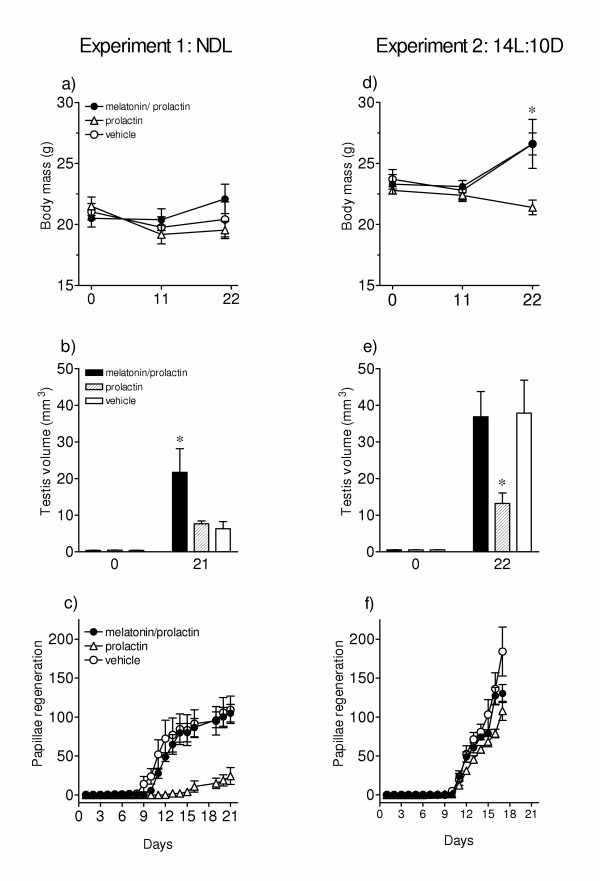
Mean (± SE) body mass, testis volume and feather papillae regeneration in response to treatment with melatonin and prolactin (group 1), prolactin alone (group 2), or vehicle (group 3) in the redheaded bunting (Emberiza bruniceps) subjected to natural day lengths at 27°N (experiment 1: a-c) for 23 days (from mid-June to early July) or to artificial day length (14L:10D; experiment 2: d-f) for 22 days. Birds were injected with exogenous hormones at a dose of 20 μg bird-1 day-1 in 200 μl of vehicle daily for first 10 days in the experiment 1 and for first 13 days in the experiment 2, and thereafter they were left uninjected. Controls received similar volume of vehicle. All injections except melatonin were made at the zeitgeber time 10 (ZT 0 = the time of sunrise for the experiment 1; the time of onset of light for the experiment 2); melatonin was injected at ZT 9.5. Day 0 on X-axis refers to the day before first injection. Under NDL, one bird of group 1 and two birds of group 2 died, and their data are excluded. Asterisk indicates the significance of difference at P < 0.05.